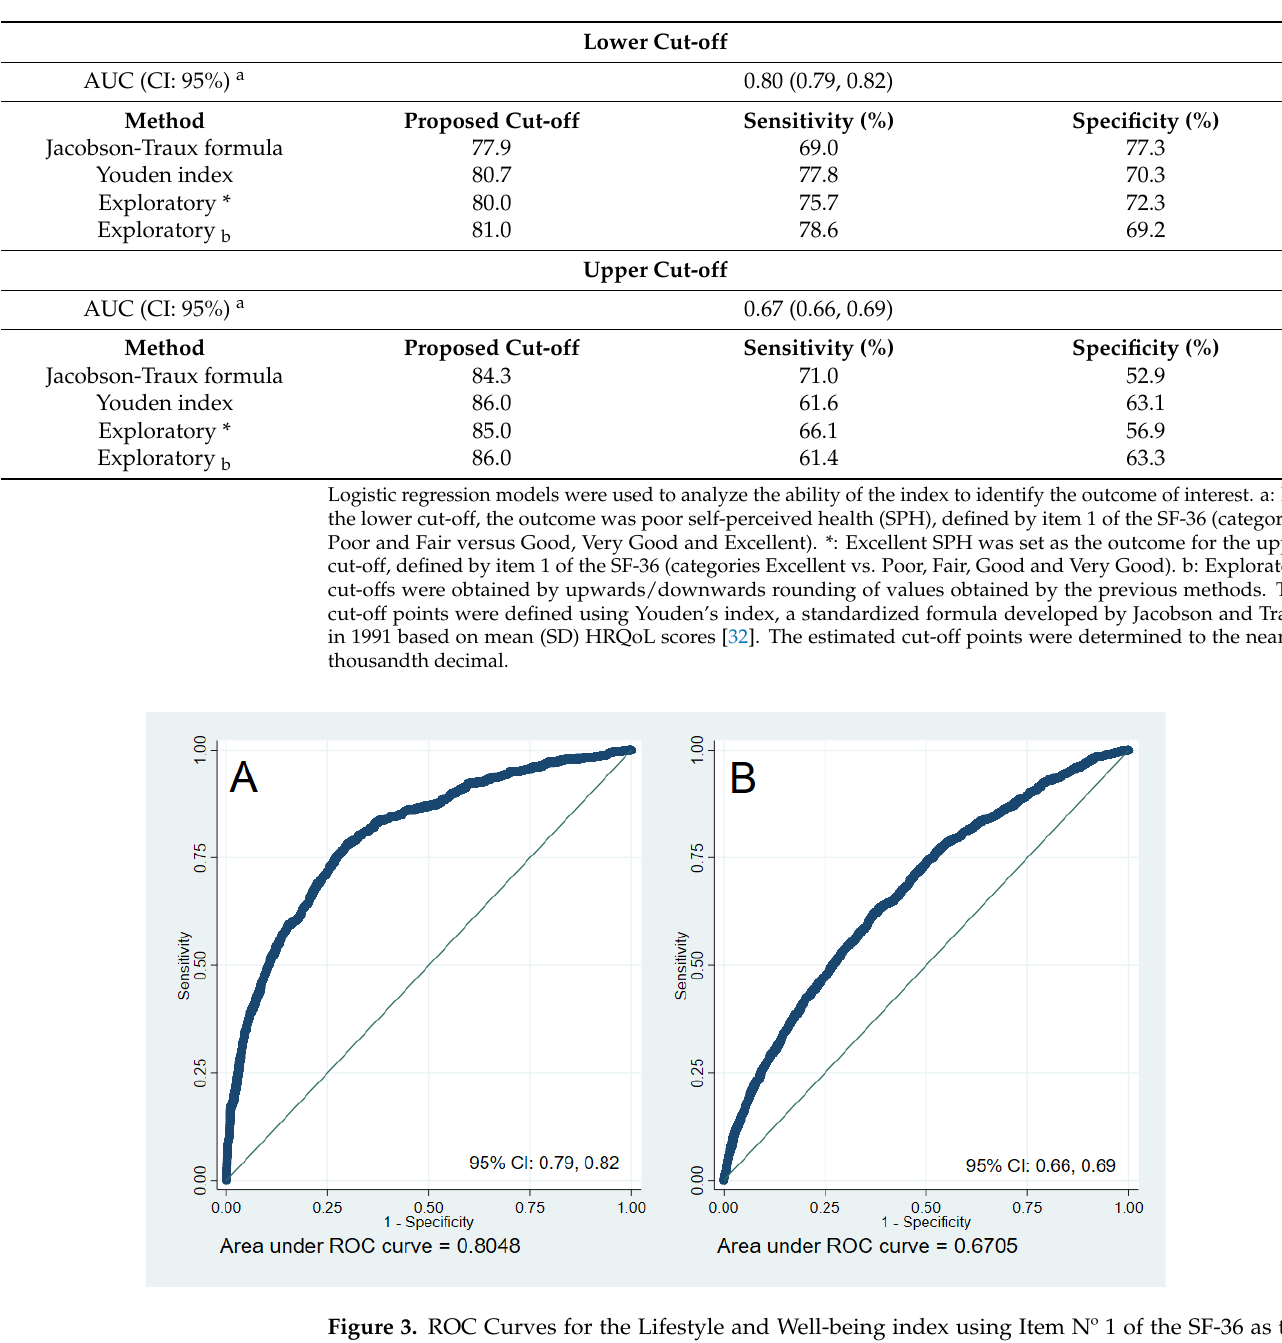
Table 3. ROC and area under the curve (AUC) analysis of the Lifestyle and Well-being Index and Sensitivity and Specificity of the Cut-off points.